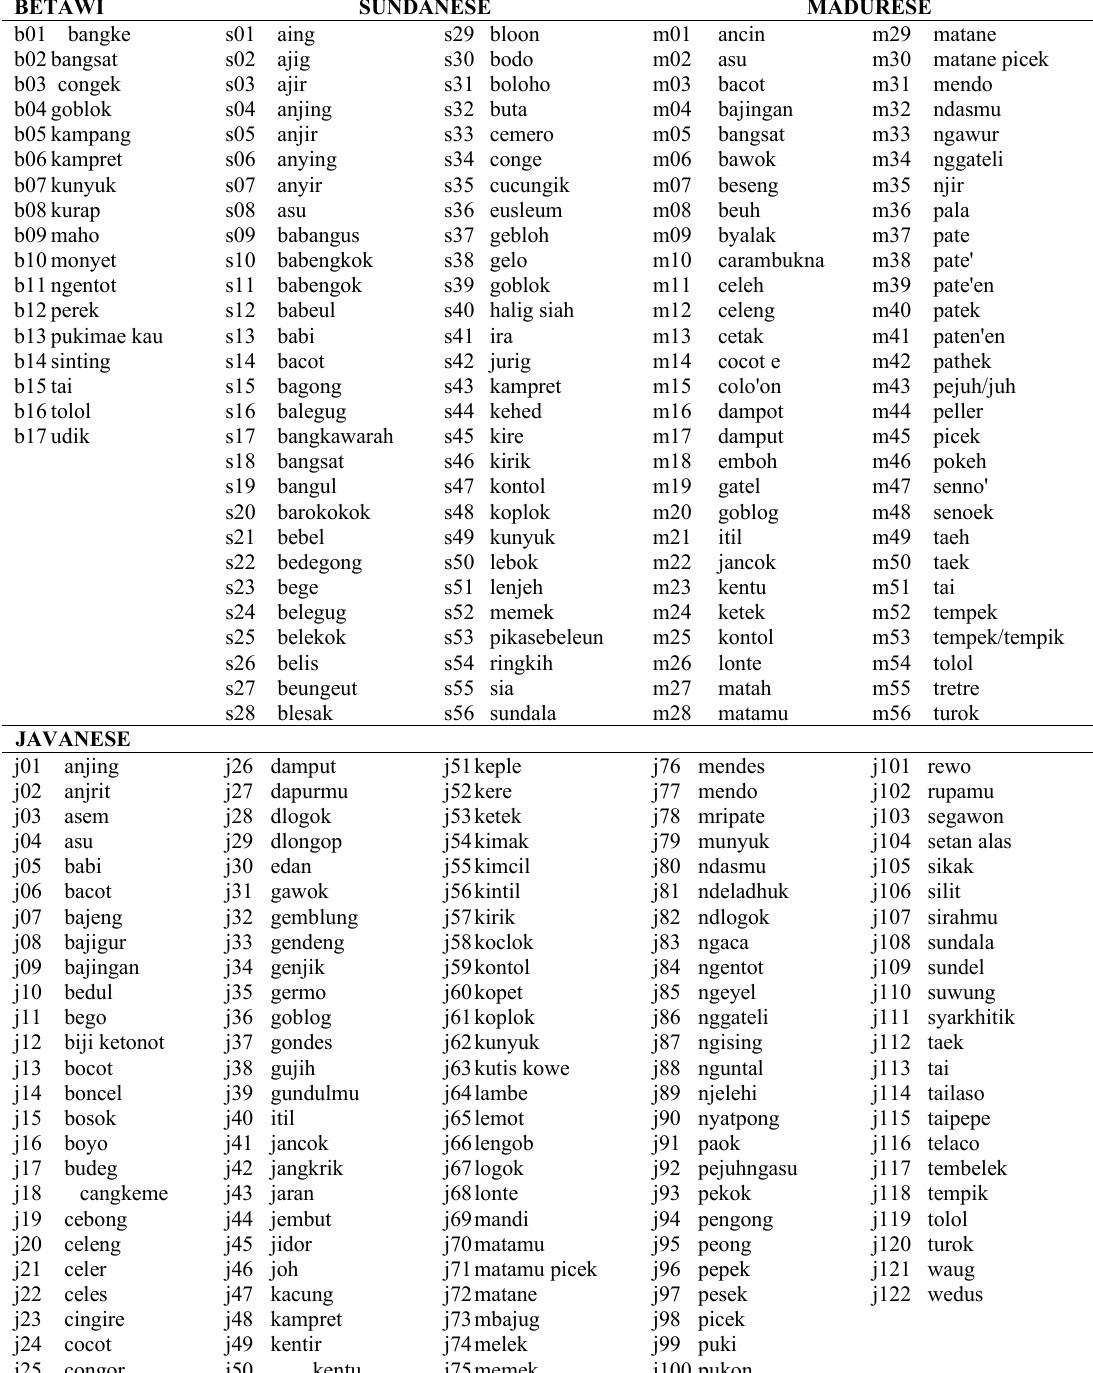
TABLE 3. LIST OF BADWORDS FROM ETHNIC